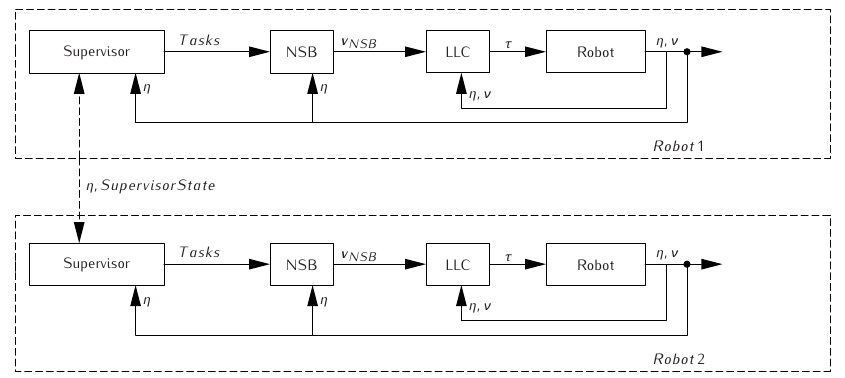
Figure 3. Control architecture of the NSB with Low-Level Control.